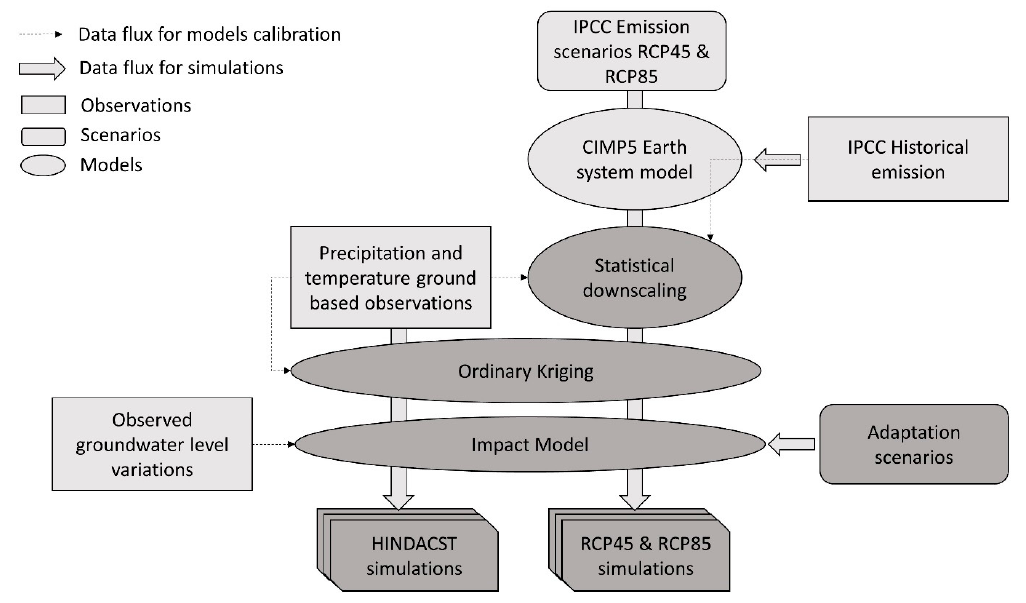
Figure 1. Block diagram of the overall conceptual model. Dash black arrows indicates data flux for calibration. Wide gray arrow indicates data flux for simulations. Dark blocks indicate steps implemented in this research.